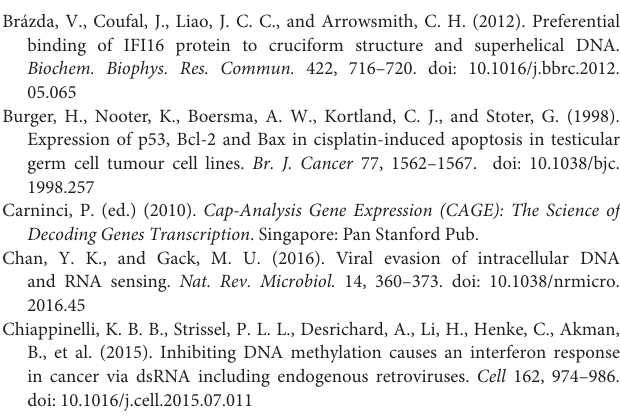
FIGURE S1 | Predicted secondary structures of oligos used in the pilot study. Oligos used in Figure 2 were analyzed using mfold by inputting the oligo sequences into the online server, using the default parameters for DNA. This typically generated three or more possible structures based on the free energy ( (cid:49) G) (Zuker, 2003). We have selected one image for each of four oligos: (A) HK2 env , (B) HK2 env mut, (C) HK2 env Scrambled 2 and (D) HK113 LTR. FIGURE S2 | Predicted secondary structures of the HK113 oligos. The oligos showing the strongest interaction with IFI16 on the western blot were analyzed using mfold. The structure predictions were obtained by inputting the oligo sequences into the online mfold server, using the default parameters for DNA. This typically generated three or more possible structures based on the free energy ( (cid:49) G) (Zuker, 2003). We have selected one image for each of four oligos: (A) Peach, (B) Carrot, (C) Cherry and (D) Kiwi. FIGURE S3 | Model of IFI16 protein–protein interactions. Known and predicted interactions of IFI16 with other cellular proteins, including the IFN signaling pathway members TBK1 and IRF3. Importantly, IFI16 interacts with key cell cycle and tumor suppressor proteins such as p53, indicating that its functions extend beyond the innate immune signaling pathway. The STRING database (Szklarczyk et al., 2017) was used to model the interactions with human